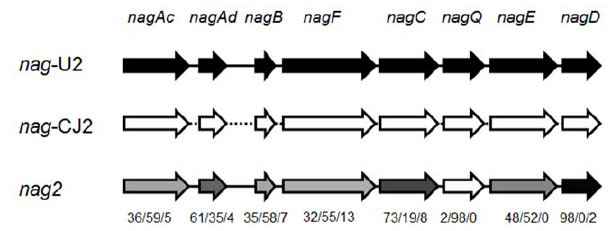
Figure 5. Structure of the nag operons revealed by BGT and pyrosequencing. The nag2 operon was of a mosaic-type pattern. The gray scale of individual genes within the nag2 operon indicates % similarity to nag -U2 (black) or nag -CJ2 (white). The numbers beneath the nag 2 operon indicates the % similarity to nag -U2/ nag -CJ2/neither.